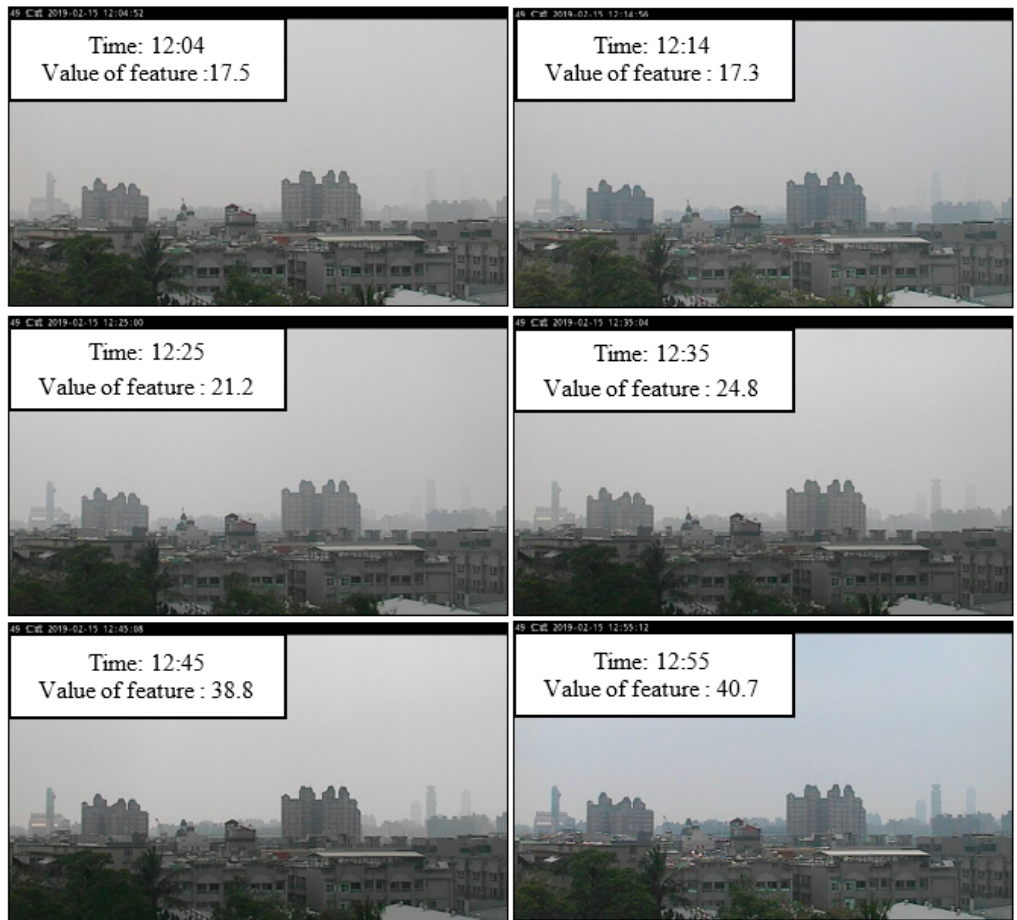
Figure 11. Value of feature change within one hour.